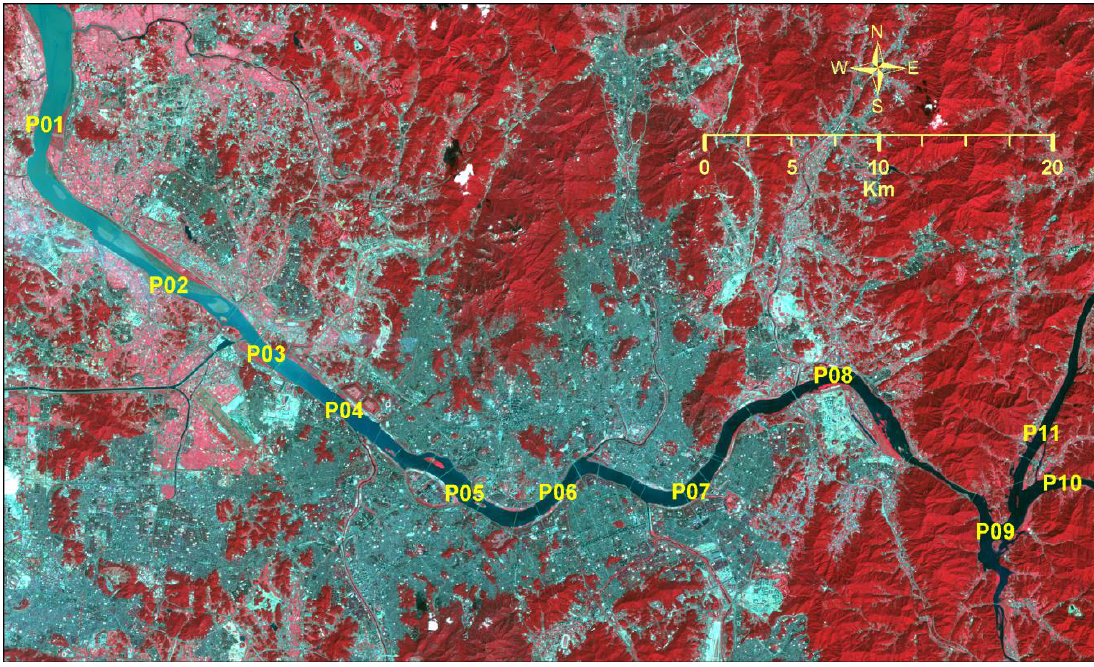
Figure 1. The Han River, Seoul and vicinity. This Landsat 8 imagery was composited using the infrared, red and green bands for red, green and blue colors, respectively. This image was taken in